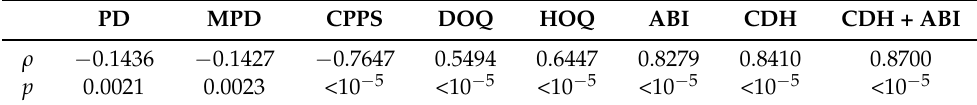
Table 3. Spearman Correlation Coefficients, ρ ( p -Values). BR: breathiness rating, PD: Pitch Differ- ence, MPD: Pitch Difference in Mel scale, CPPS: Cepstral Peak Prominence, DOQ: Open Quotient with DECOM method, HOQ: Open Quotient with Howard method, CDH: CPPS + DOQ + HOQ, CDH + ABI: CPPS + DOQ + HOQ +